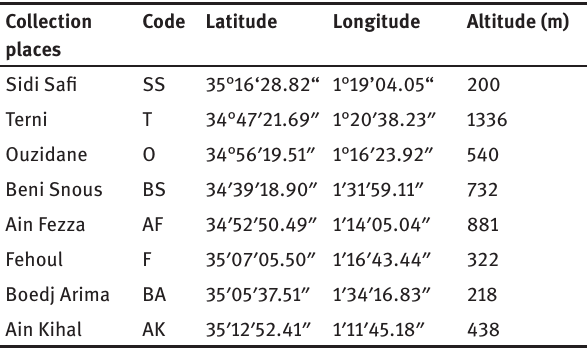
Table 1 : Ammoides pusilla collection sites in Algeria and corresponding